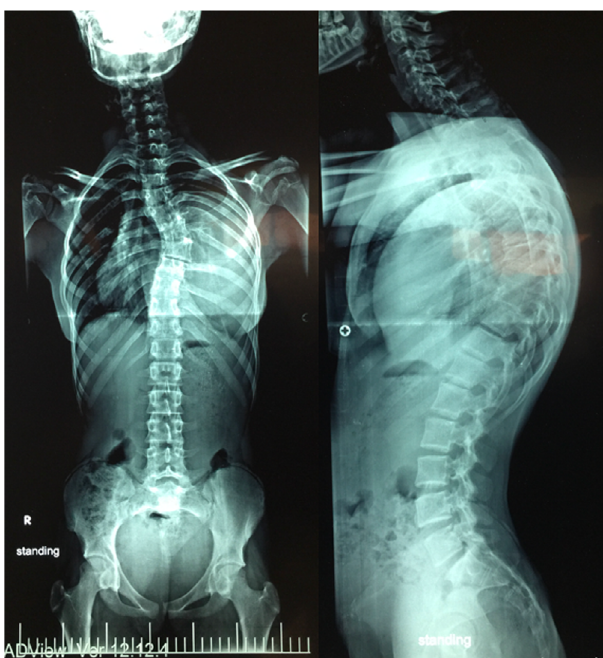
Figure 1. Preoperative full-length PA and lateral whole spine X-rays showing a 50 (cid:1) right thoracic scoliotic with thoracic kyphosis of 65 (cid:1)